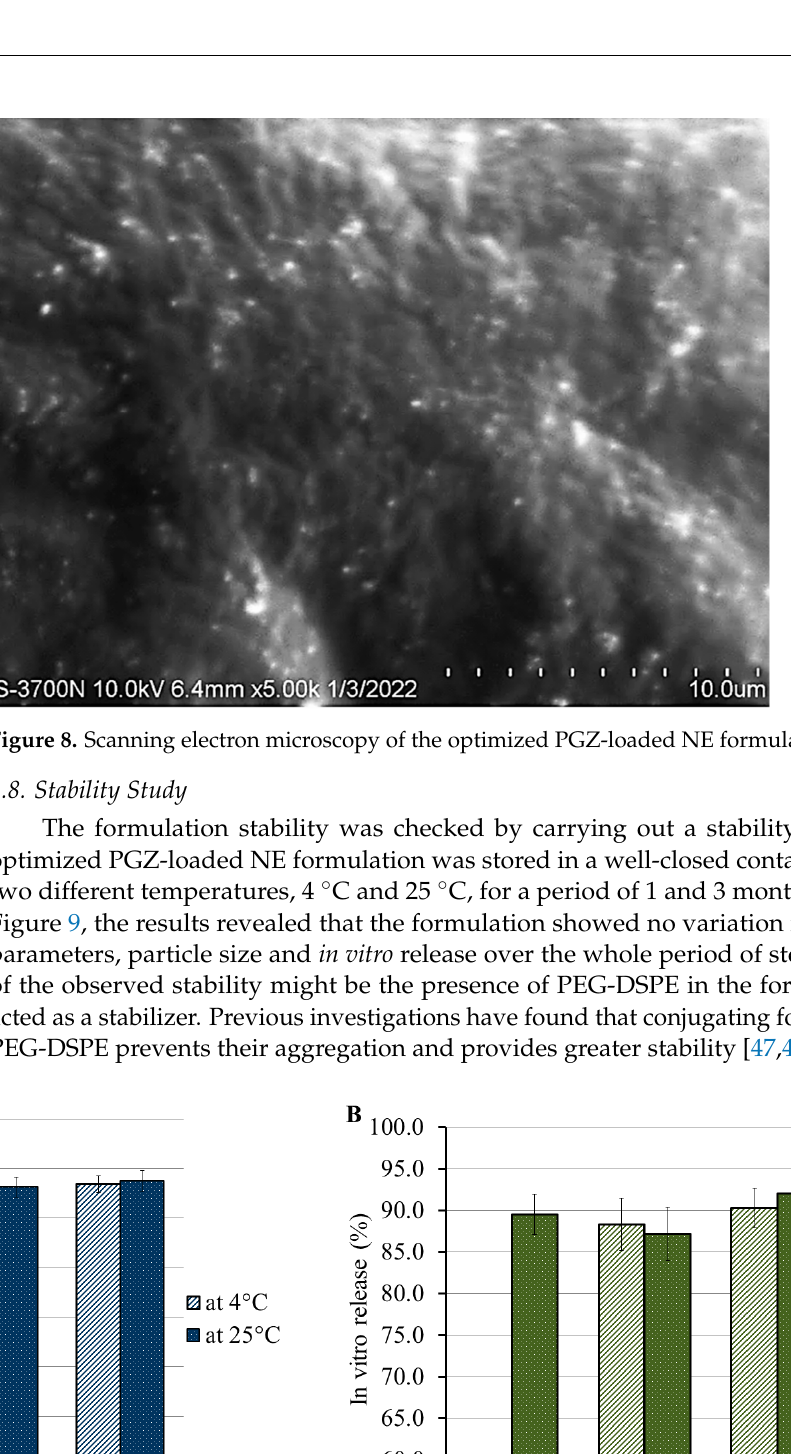
12 of 17 Table 5. The correlation coefficient value for different kinetic modeling mechanisms . Formula